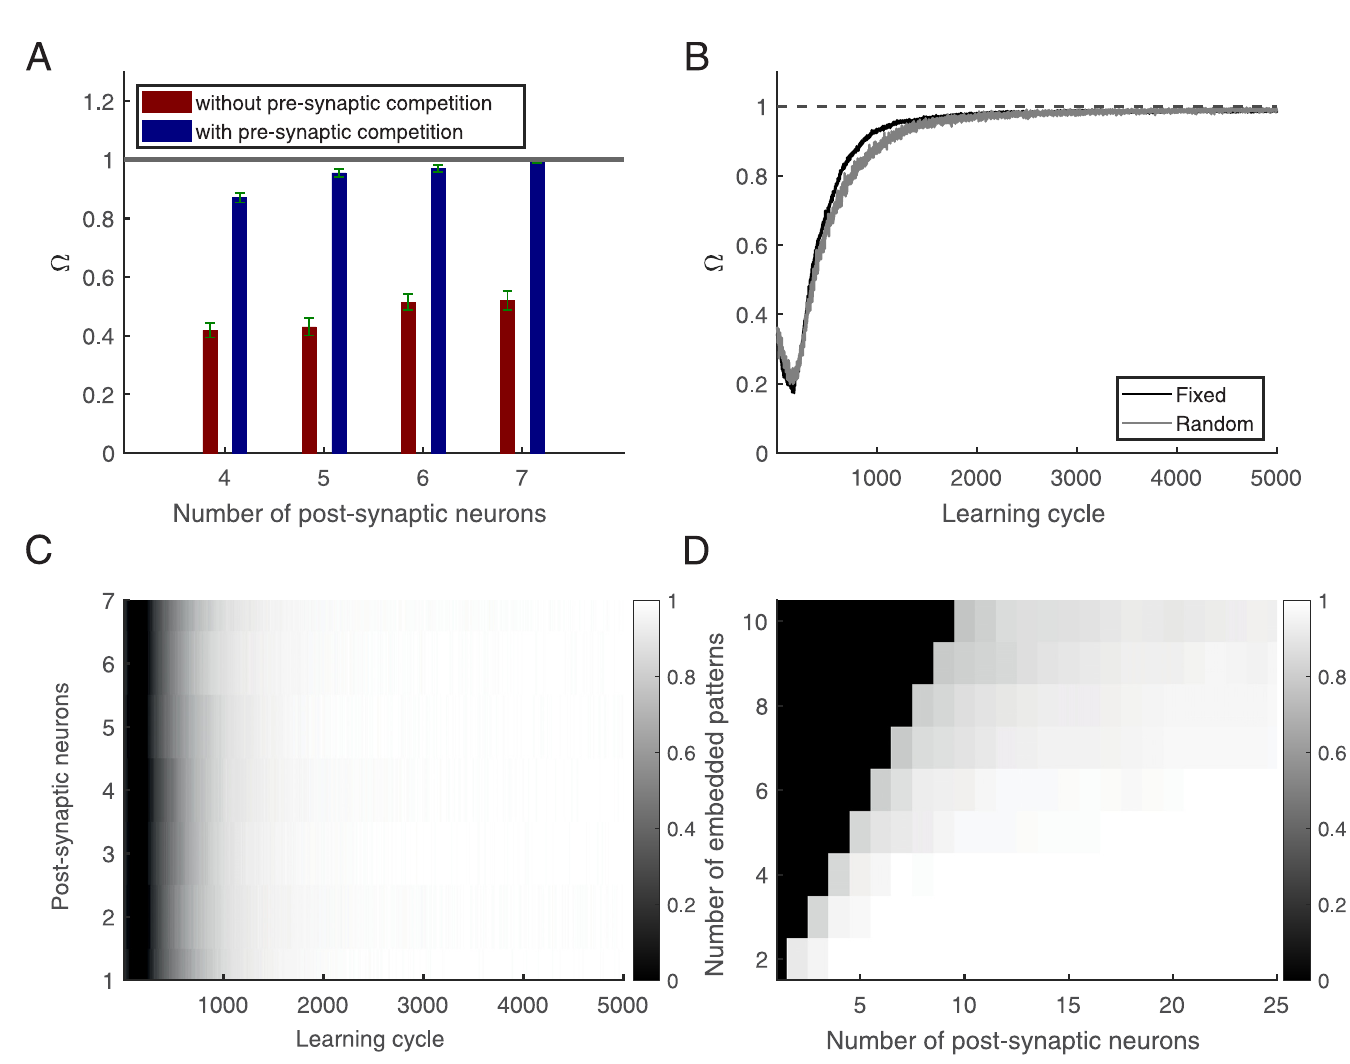
Fig 9. Self-supervised neural networks. (A) The system’s O (rank/4) versus the number of post-synaptic neurons after learning. (B) O versus learning cycle (There are 7 post-synaptic neurons). Black line: Each pattern is shown in each learning cycle in a fixed position. Gray line: Each pattern is shown in the epoch with the probability of 0.2 at a random place. (C) Each row shows the mean R values for the case of 7 post-synaptic neurons. (D) O : number of post-synaptic neurons to separate different numbers of embedded patterns ( O is computed when the number of post-synaptic neurons equals or exceeds the number of embedded patterns.) (A) , and (D) are based on an average of 50 simulations. (B) and (C) are based on an average of 500 simulations. In all simulations, the epoch length is 1000 ms, the embedded patterns’ duration is 50 ms, L = 15 ms, and r 0 = 2 Hz. In (A) , (B) , and (C) , there are 4 different independent embedded patterns in each